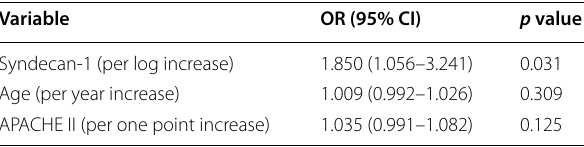
Table 2 Multivariable logistic regression model for hospi- tal mortality in 262 sepsis patients Variable OR (95%